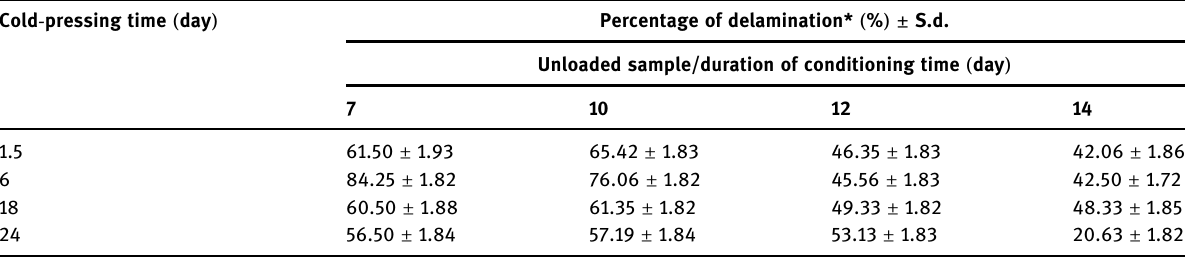
Cold - pressing time ( day ) Percentage of delamination* ( % ) ± S.d.